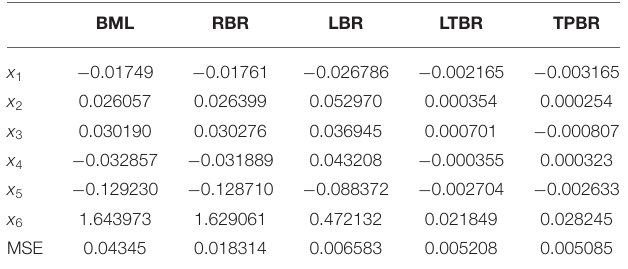
TABLE 5 | The estimated coefficients and MSE values for the used estimators (football data).